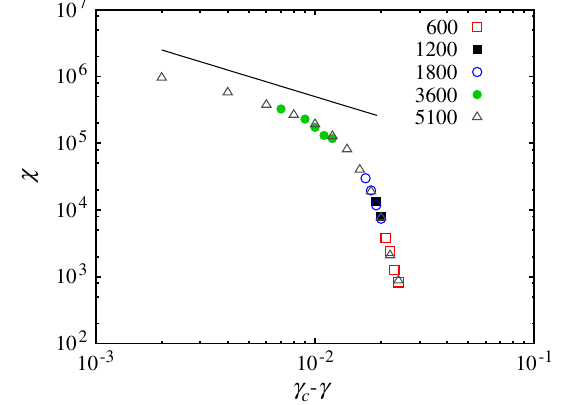
FIG. 8. Fluctuations of the amplitude of oscillations (cid:4) in dependence on the vicinity to the critical value of the cost ¼ 0 : 1242 ð 6 Þ for (cid:1) ¼ 0 : 55 and different system sizes, as (cid:2) c indicated in the legend. The slope of the power-law exponent (solid line) is 1, indicating divergent fluctuation as (cid:2) approaches the critical